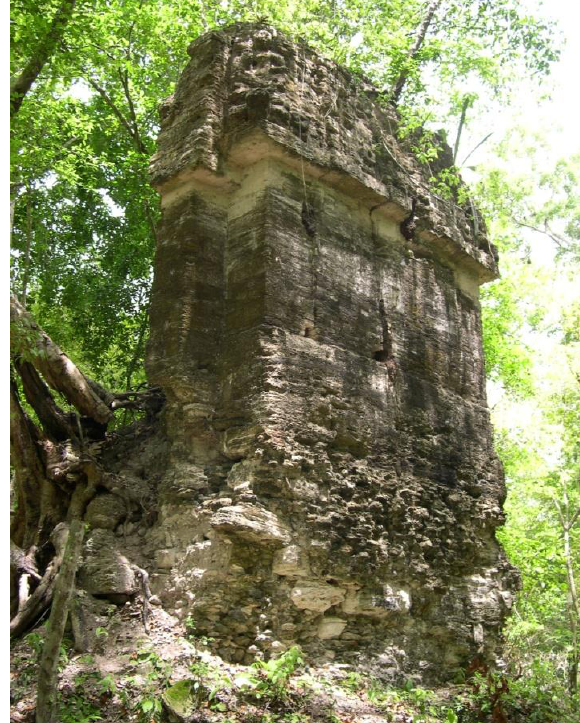
Figure 2. Looted and eroded building at Corozal Torre, in the rainforest, Petén, Guatemala. (Photo G. Muñoz 2003).